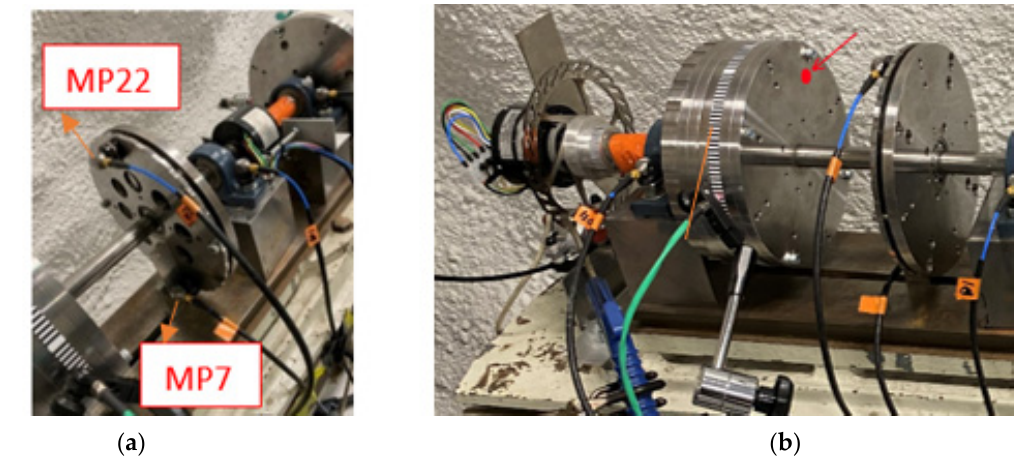
Figure 6. Detail of sensor setup and unbalance mass attachment. ( a ) sensor at disc2, ( b ) location of added unbalance.